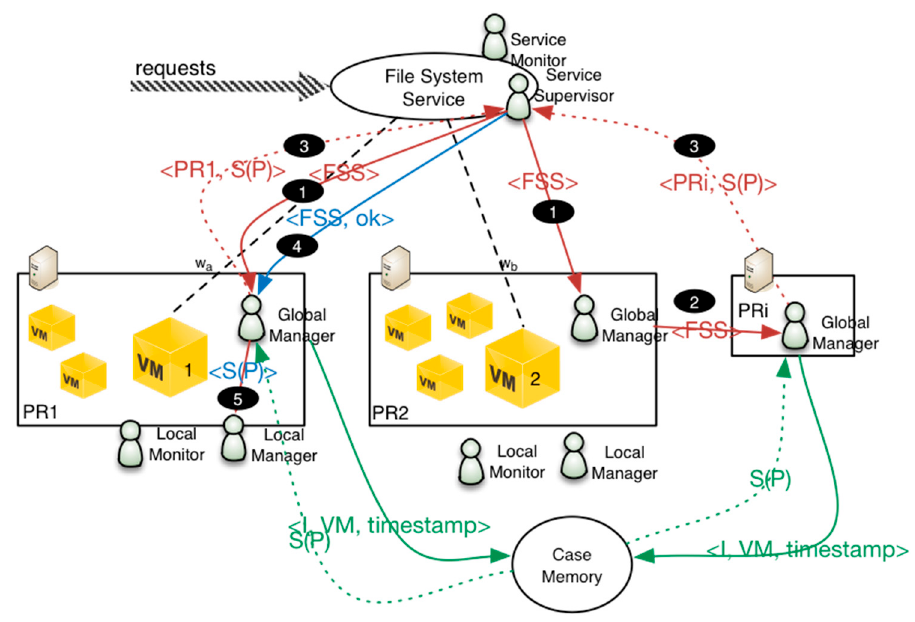
Figure 6. Exchange of messages in the infrastructure distribution during the experiment.